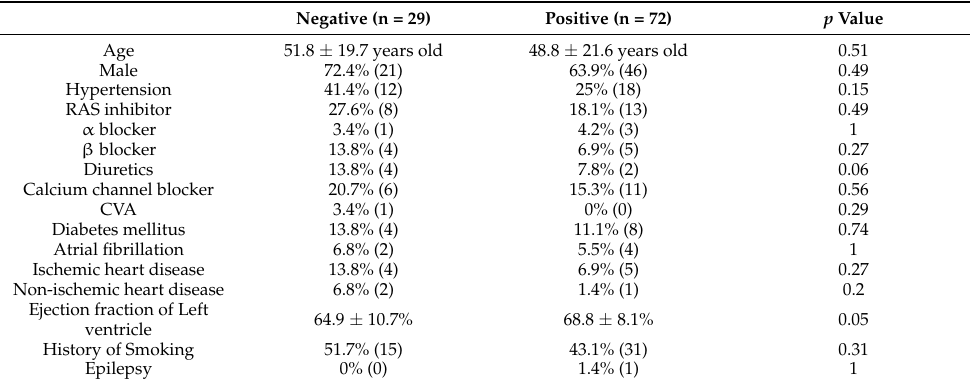
Table 1. Baseline clinical characteristics of the study